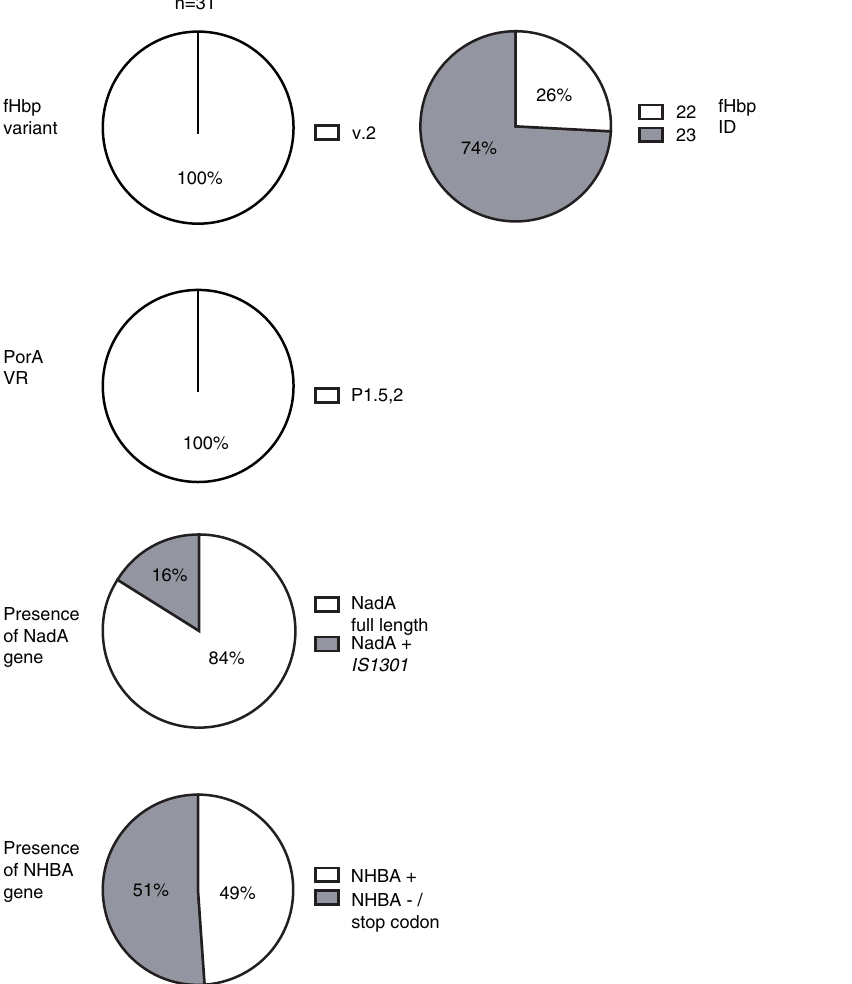
compared to the reference strain (Figure 2). There was no significant difference in fHbp expression between case and carrier isolates studied ( P =0.74, Mann Whitney U test). This indicates that levels of fHbp protein on the bacterial surface can vary among strains collected from a relatively small region and expressing the same fHbp